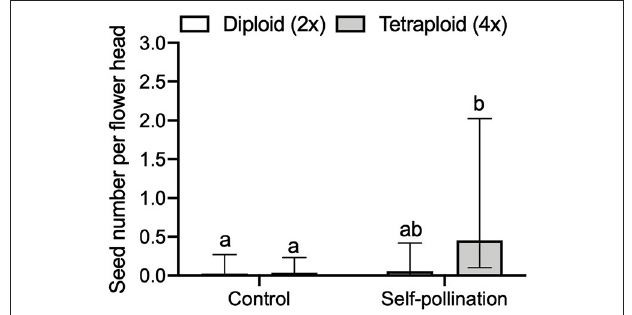
FIGURE 6 | Comparison of seed number per flower head between control (no pollen transfer) and self-pollination in red clover. Error bars indicate the 95% confidence interval of the estimated marginal means (EMMs). EMMs sharing a lowercase letter within the same figure are not significantly different at 0.05 significance level.